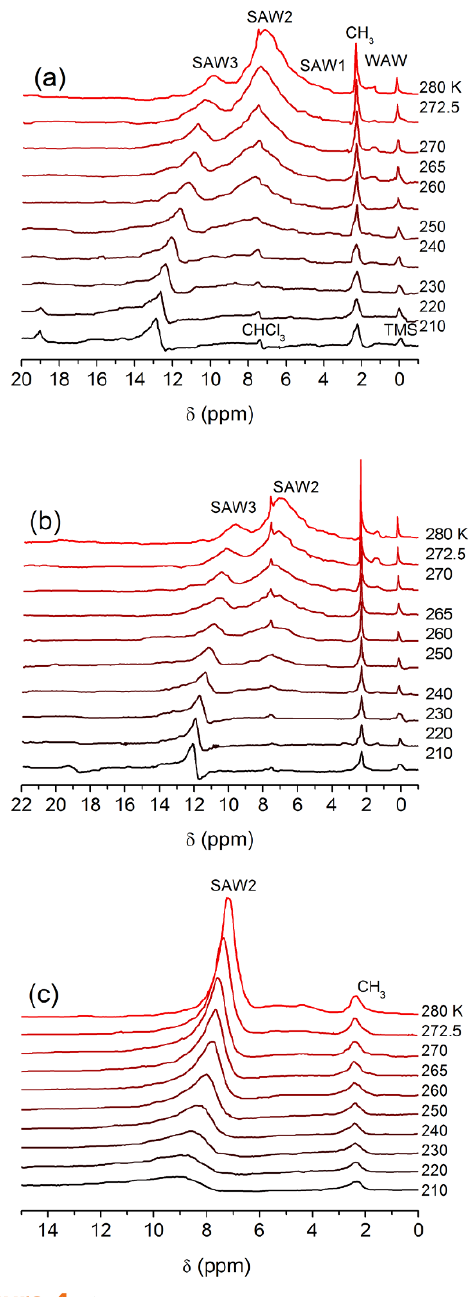
Figure 4. 1 H NMR spectra of water bound to NC in different media with CDCl /(CD ) CO mixtures at the ratio: (a) 15/1 and 3 3 2 (b) 5/2 and in acetone at h = (a, b) 38 mg g -1 and (c) 100 mg g -1 . of the textural characteristics of NC at h = 1 g g -1 without acetone (in the CDCl medium) and at h = 0.1 g g -1 in the 3 acetone-d medium and in the CDCl /(CD ) CO mixtures 6 3 3 2 (Table 1). The rearrangement of the NC structure under the acetone affects changes in the structure of the water clusters bound to the NC particles (Figs. 5 and 6 ). An